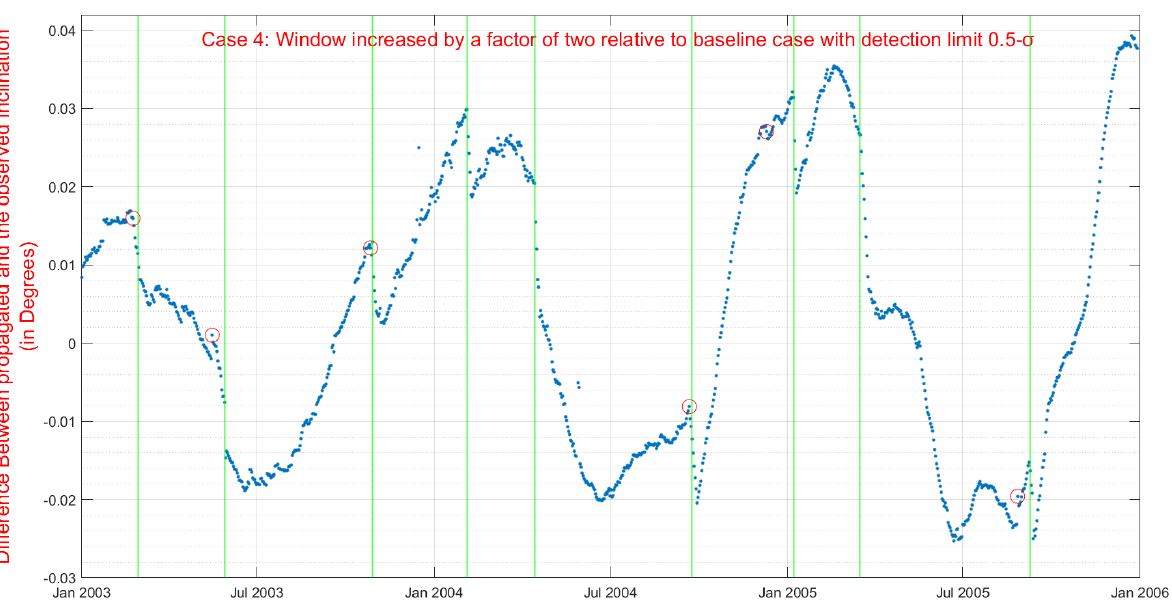
Figure 7. Case 4: Window increased by a factor of two relative to baseline case with detection limit 0.5-sigma. Vertical green lines represent the maneuvers and the red circles represent potential maneuvers detected by this